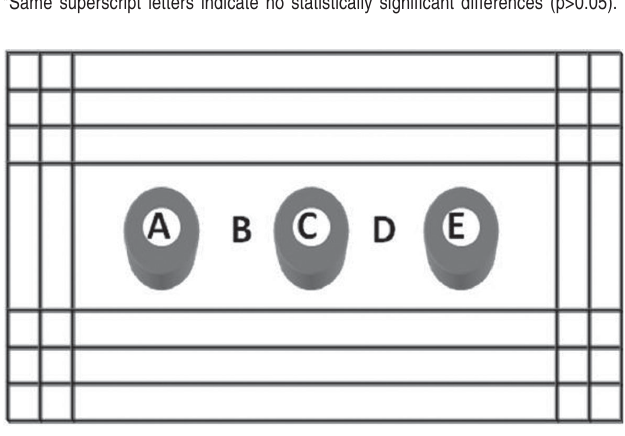
Fig. 4 - Five points of load application (A, B, C, D and E)